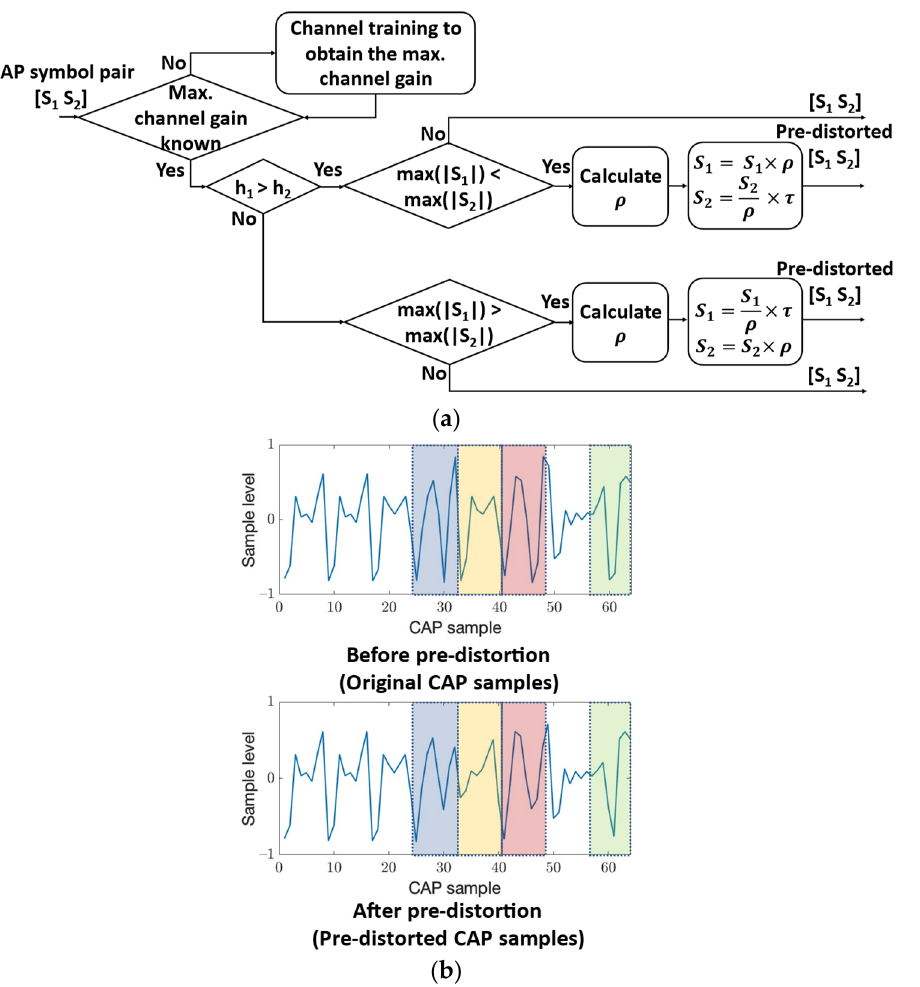
Figure 2 . Signal pre-distortion technique. ( a ) Signal flow for pre-distortion. ( b ) Example of the generation of a pre-distorted CAP waveform.